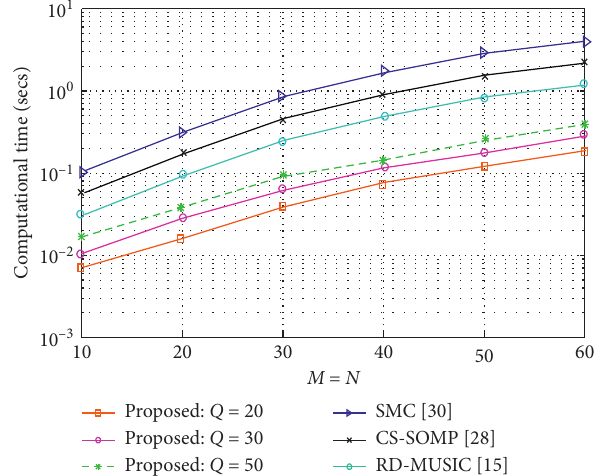
Figure 8: Computational time against number of antennas ( M � N ).